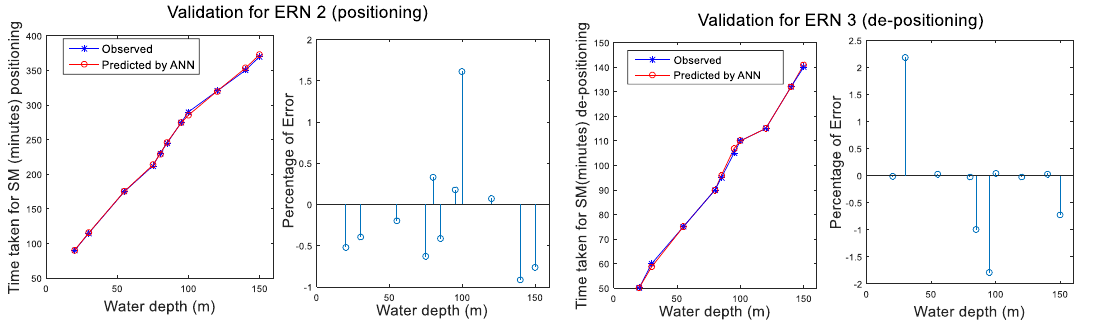
Figure 9. Comparison plot for observed and ANN predicted values (FO consumption for SM setup).